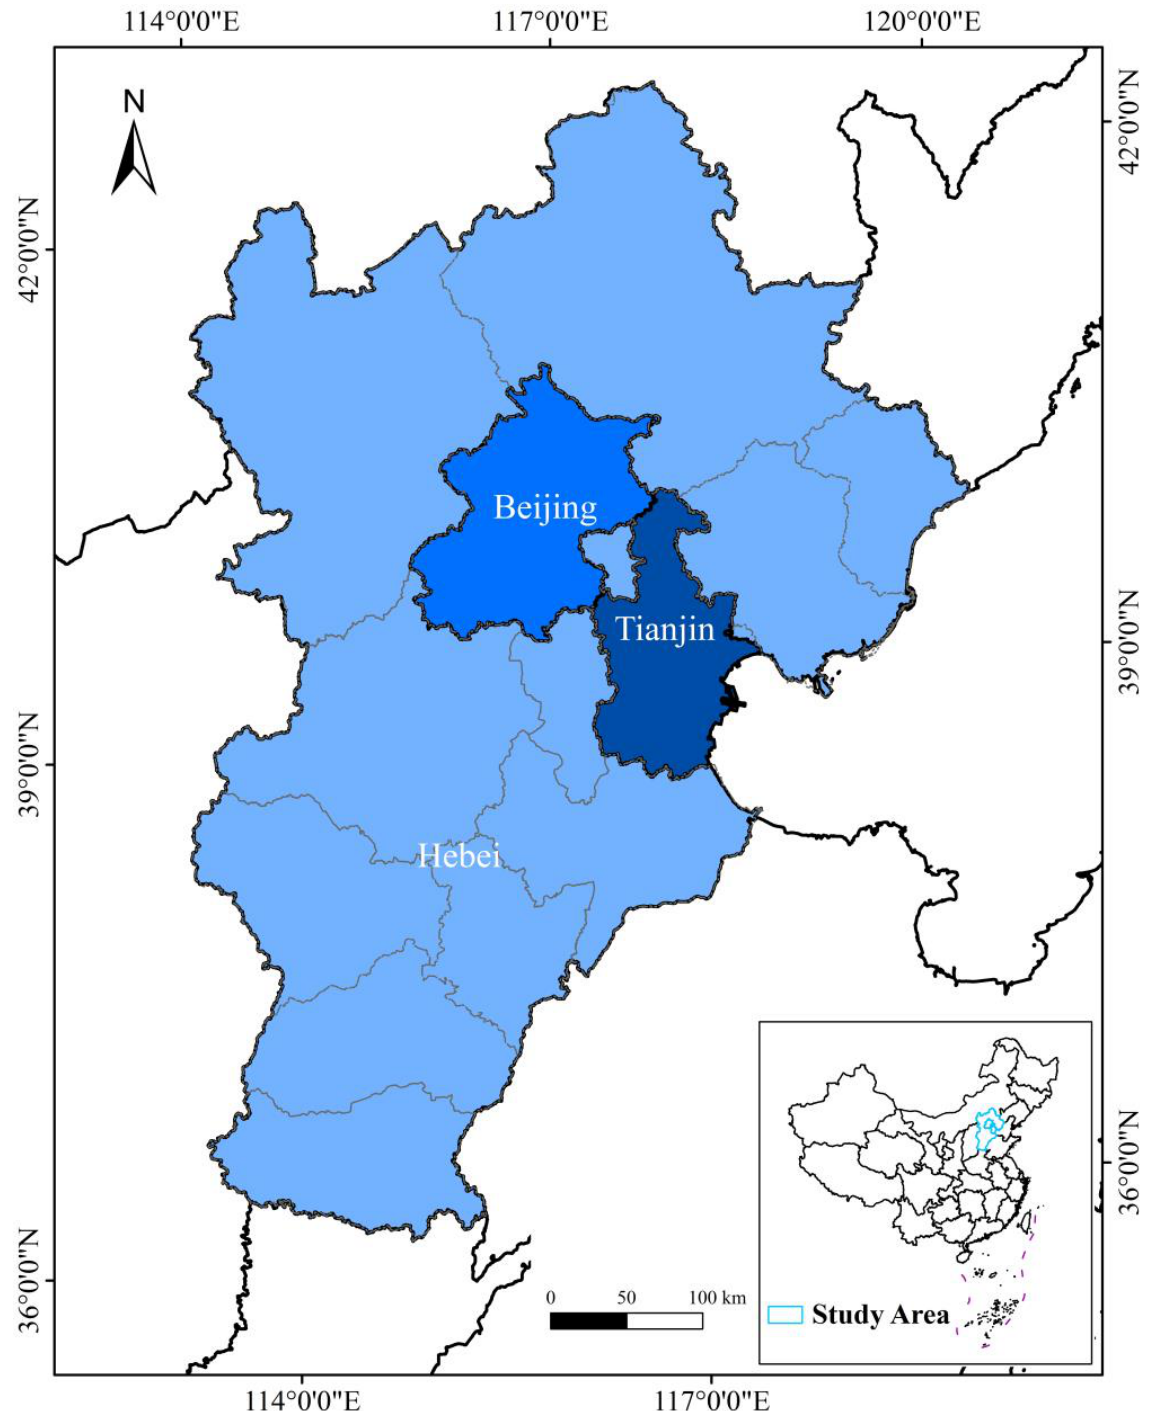
Figure 1. The geographical location of the study area.